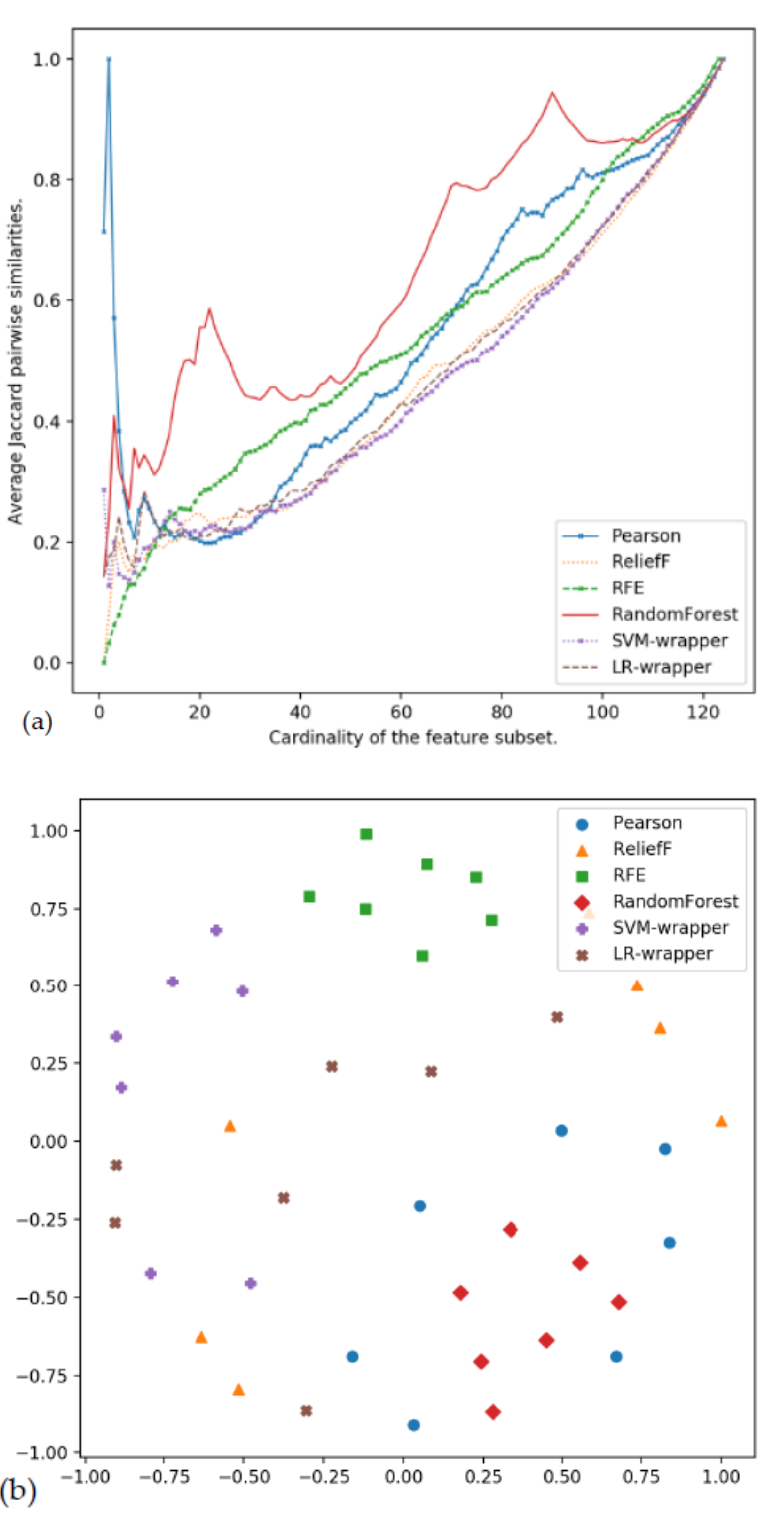
Figure 6. Feature selector stability: ( a ) Jaccard index for feature subsets with different cardinality; ( b ) MDS plot of the feature ranking